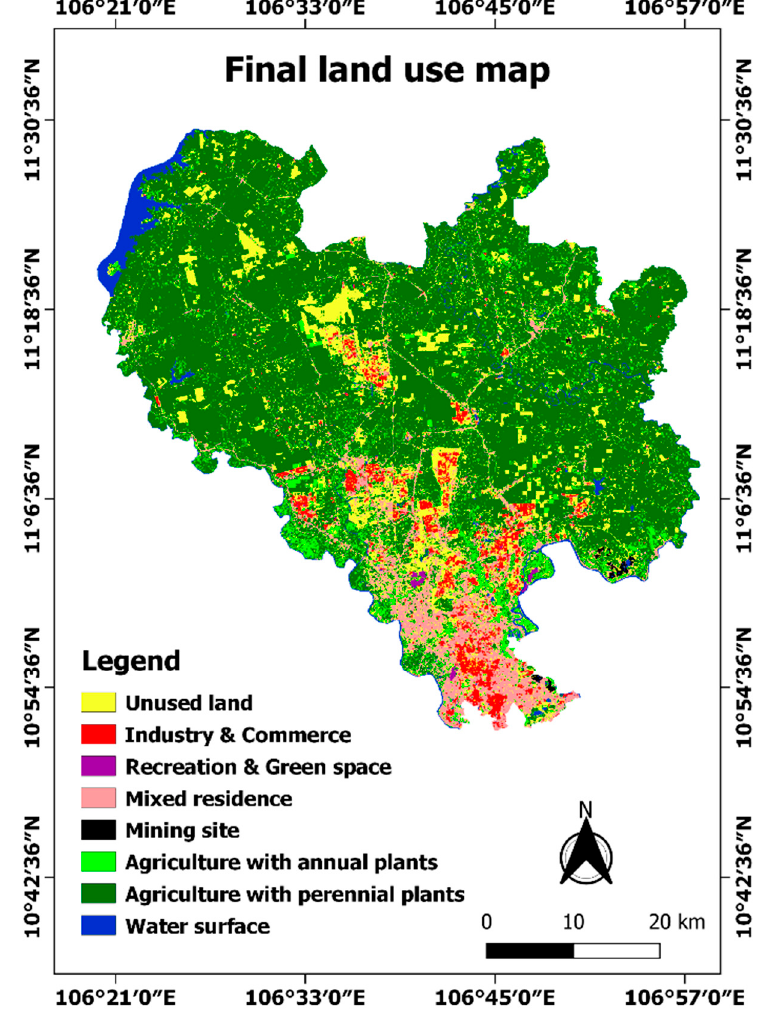
Figure 11. Final land use map.